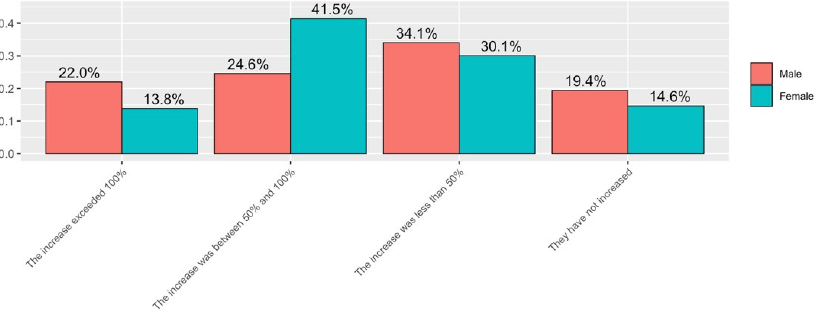
Figure 13. Answers to Q5 disaggregated by gender.